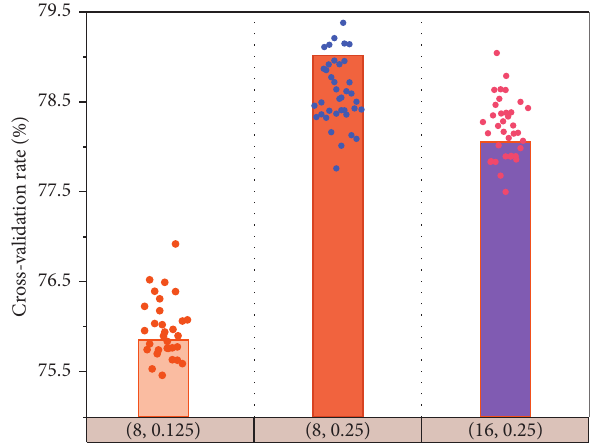
Figure 7: Parameter combination and cross-validation accuracy of prewarning.